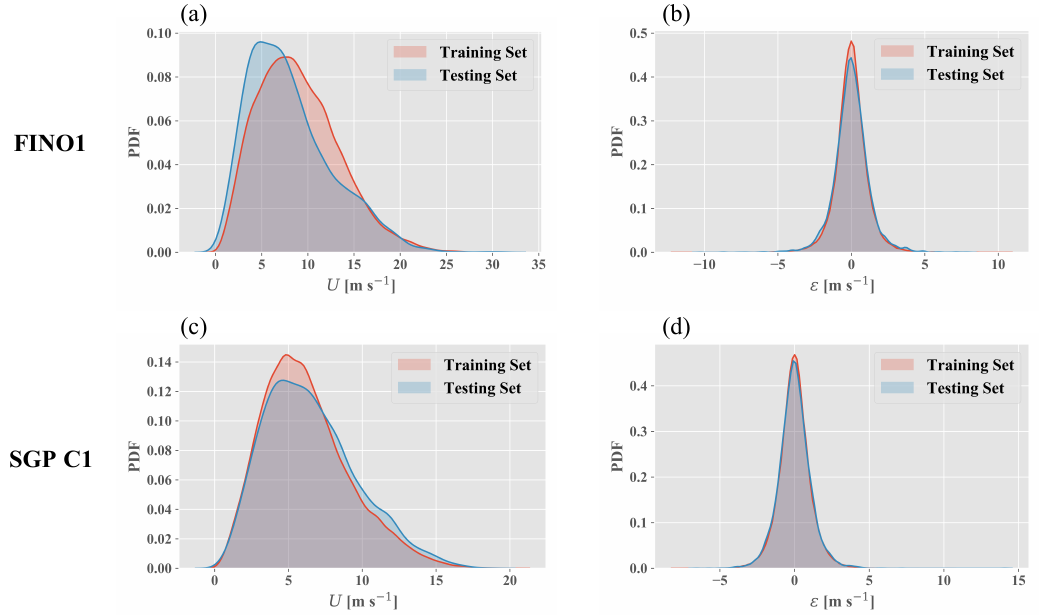
Figure 2. Probability distribution functions (PDFs) of ( a,c ) U and ( b,d ) ε for the FINO1 (top row) and SGP C1 (bottom row) datasets. Red shading represents training set distributions, while blue shading represents testing set